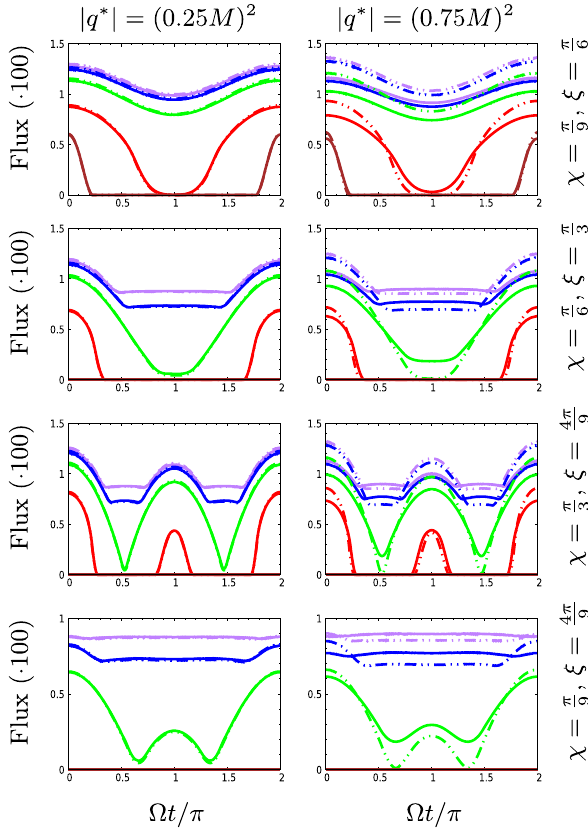
Fig. 10 Pulse profile for antipodal caps. h = 3, R / r h = 3. Purple, blue, green, red and brown lines correspond to (cid:11) = 0 . 00, 0 . 30, 0 . 60, 0 . 90 and 0 . 99 respectively. Solid lines correspond to q ∗ > 0 while dashed lines to q ∗ < 0. The rows, from top to bottom, correspond to Beloborodov classes I, II, III and IV. Both the q ∗ and (cid:11) modify the morphology according to the metric. As q ∗ increases, R